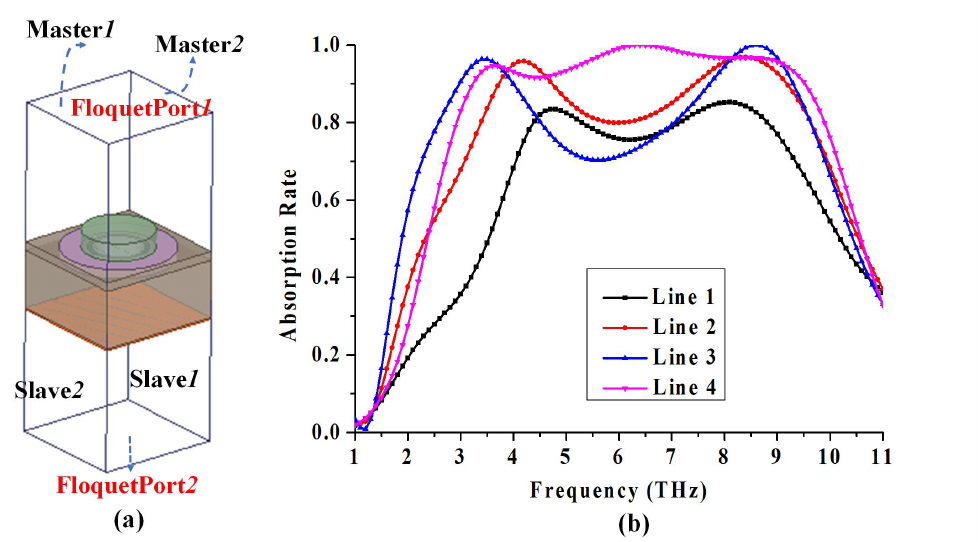
Figure 3. ( a ) Boundary and Excitation setting for the unit cell of the proposed absorber, ( b ) The simulated frequency responses for Line 1: with one patterned graphene layer, Line 2: with bilayer patterned graphene, Line 3: with trilayer patterned graphene, Line 4: with dielectric cylinder and bilayer patterned